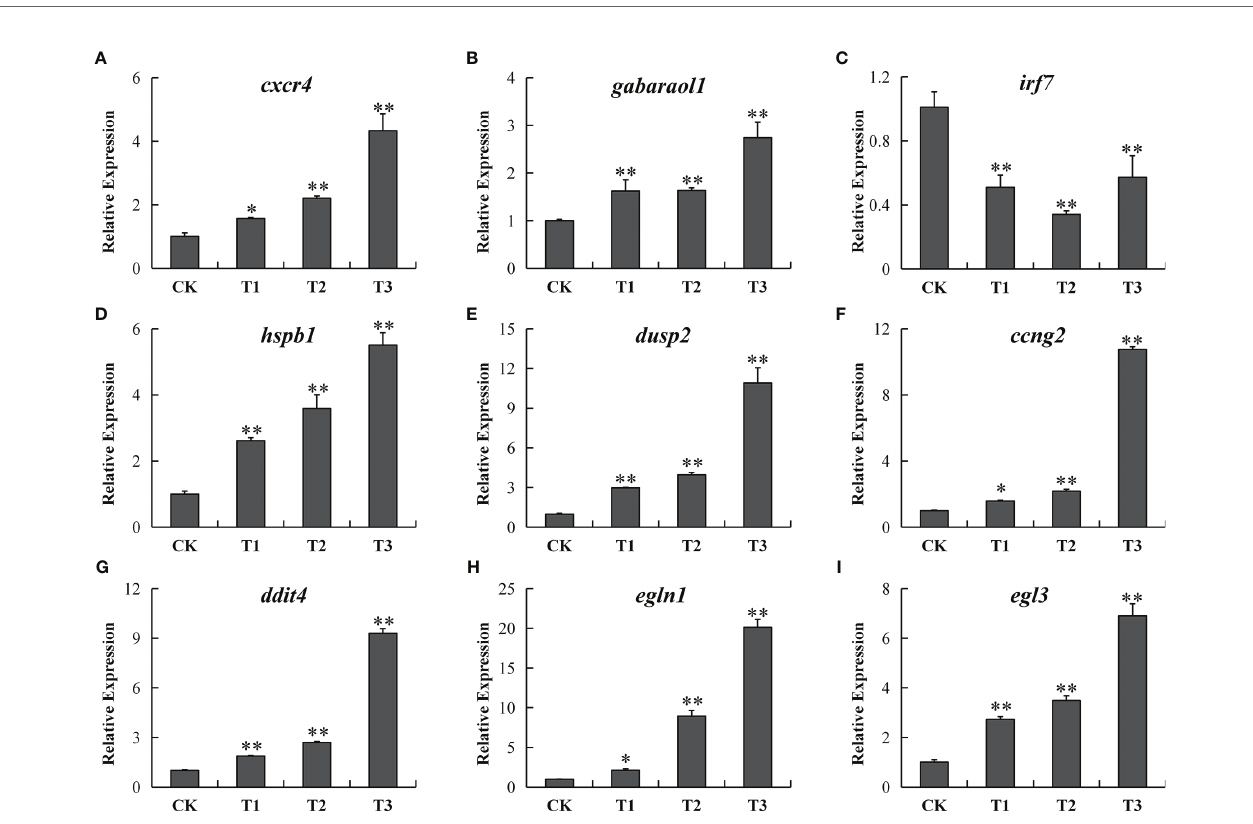
FIGURE 9 | RT-qPCR veri fi cation of 9 differentially expressed genes [cxcr4 (A) , gabarapl1 (B) , irf7 (C) , hspb1 (D) , dusp2 (E) , ccng2 (F) , ddit4 (G) , egln1 (H) , and egln3 (I) ] in the CK, T1, T2, and T3 groups. Y -axis exhibits the relative fold change. * designates P < 0.05, ** designates P < 0.01.